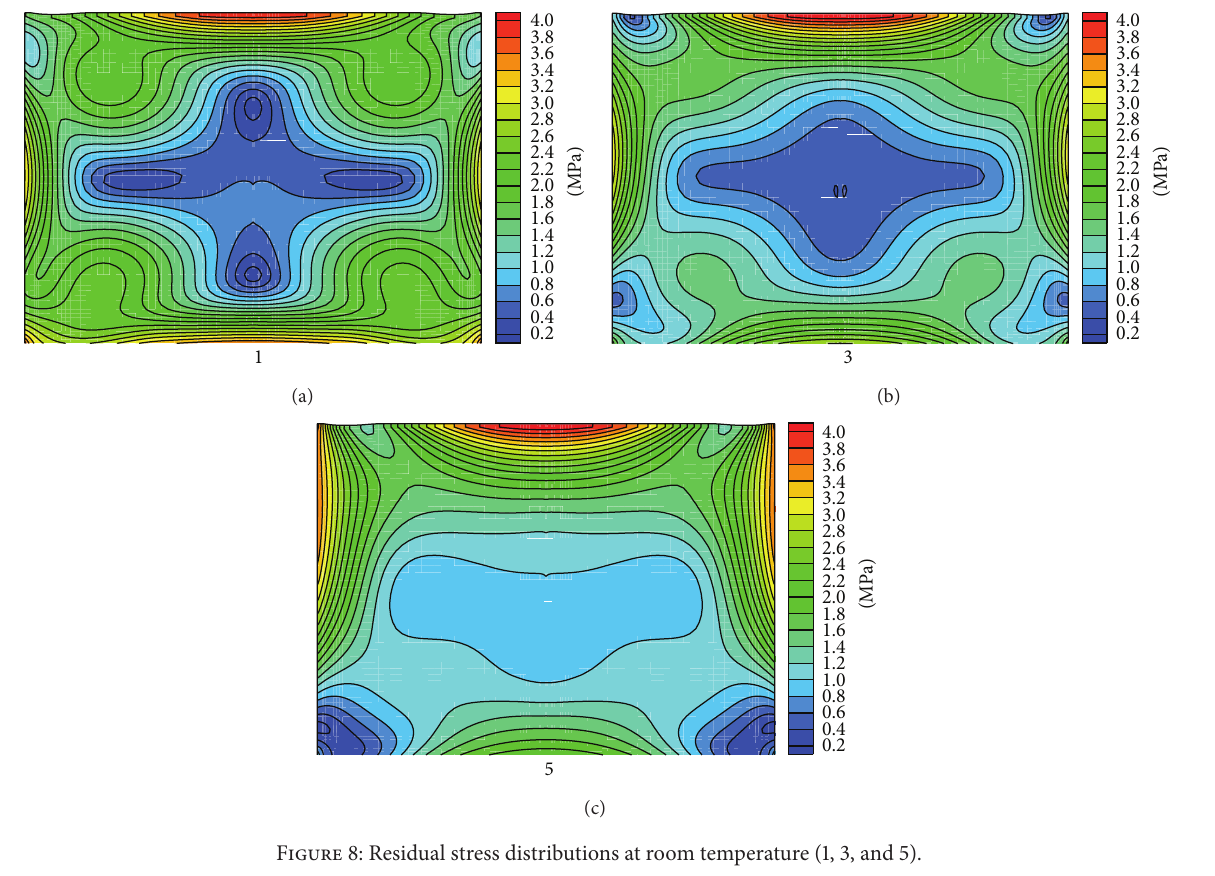
Figure 8: Residual stress distributions at room temperature (1, 3, and 5).